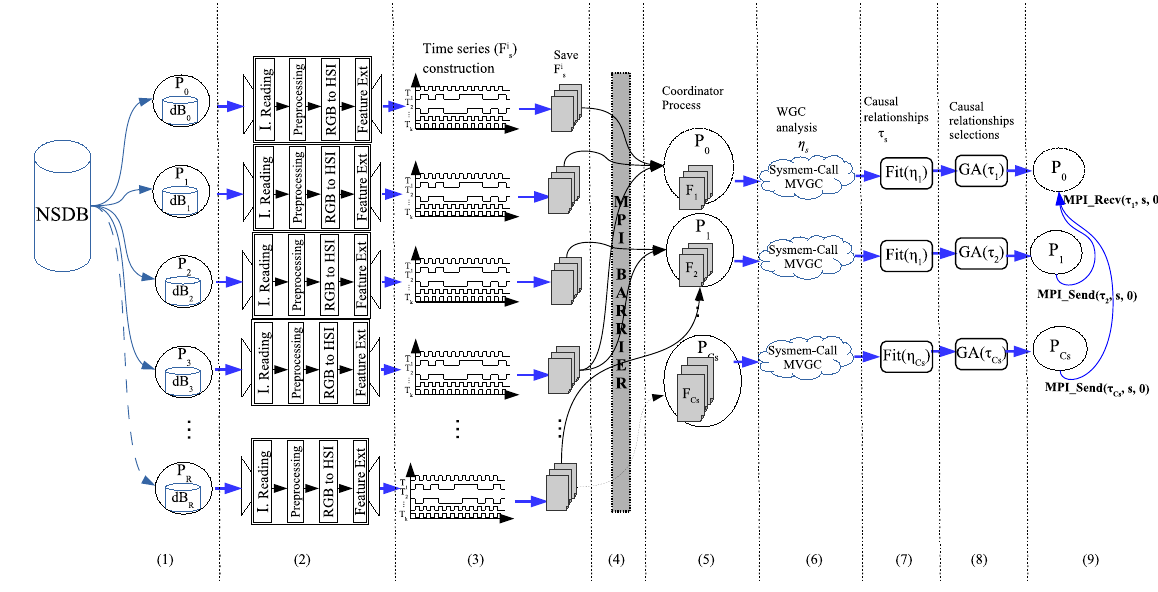
Figure 13. The proposed parallel algorithm